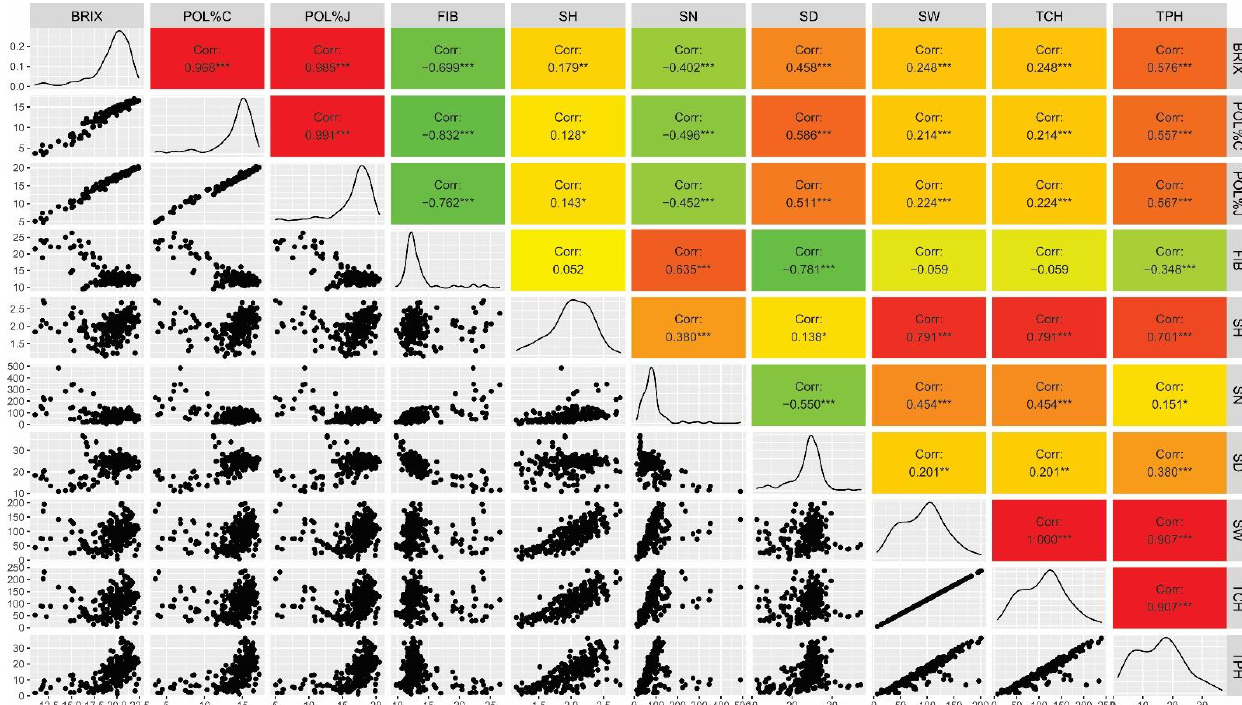
Figure 1. Genotypic correlation between yield traits [BRIX (in °Brix), sucrose content of the cane (POL%C, in %), sucrose content of the juice (POL%J, in %), fiber content (FIB, in %), stalk height (SH, in m), stalk number (SN), stalk diameter (SD, in mm), stalk weight of the plot (SW, in kg), cane yield (TCH, in t/ha) and sucrose yield (TPH, in t/ha)] evaluated in the Brazilian Panel of Sugarcane Genotypes (BPSG). For each trait, the density plots of the adjusted means (diagonal), scatterplots (below diagonal), and values of the genotypic correlation (above diagonal) between pairs of traits are shown. * Significant at the 5% global level ( 𝑝 < 0.05 ). ** Significant at the 1% global level ( 𝑝 < 0.01 ). *** Significant at the 0.1% global level ( 𝑝 < 0.001 ).